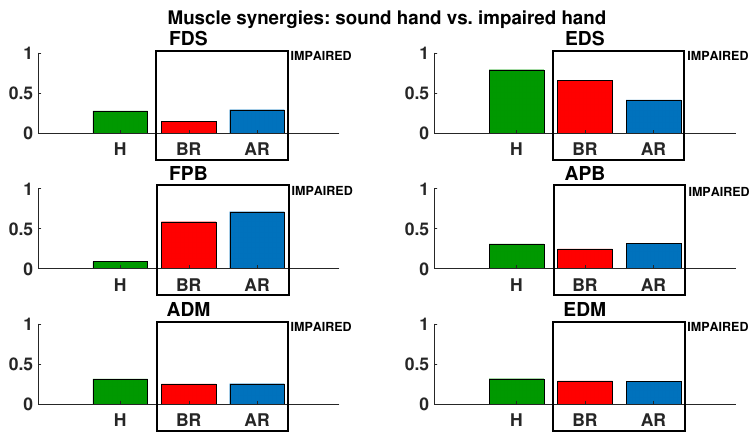
Figure 7. Comparison of the muscular synergies of the sound hand (in green) vs. the impaired hand (in the box) before (red) and after (blue) the rehabilitation treatment with the Gloreha robot for